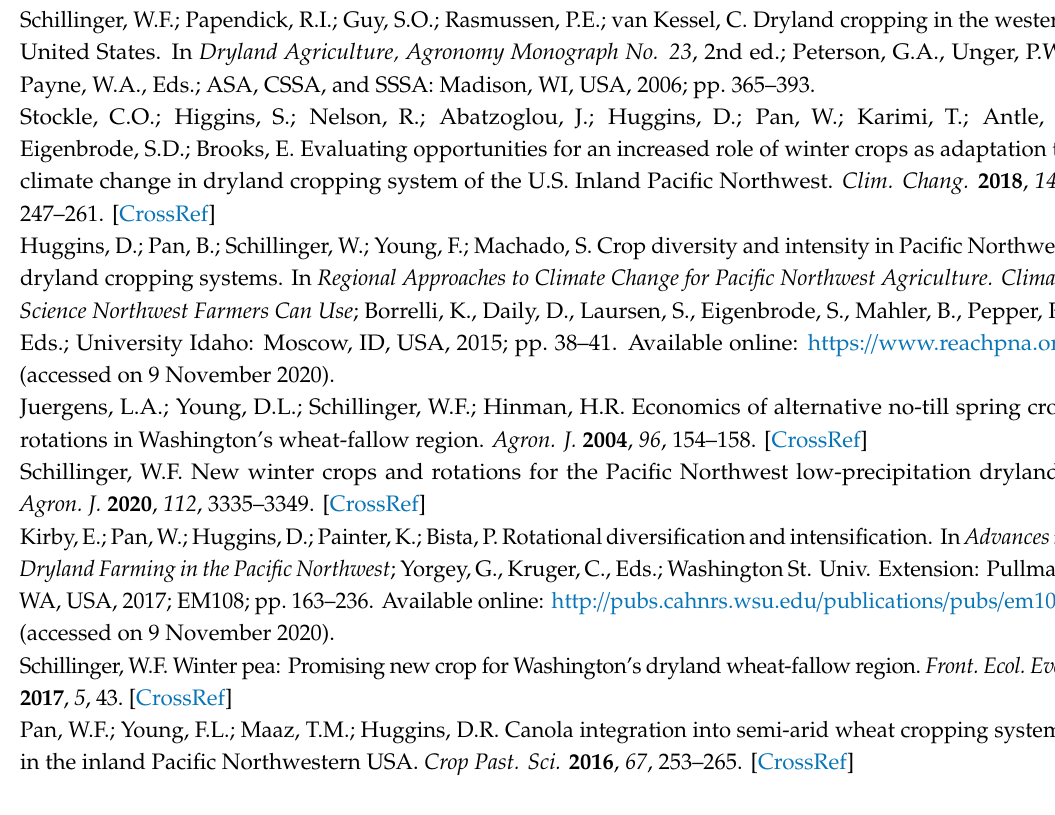
Table S1: Annual (September 1) soft white wheat and triticale market prices in US dollars from 2012-2019 at Ritzville,